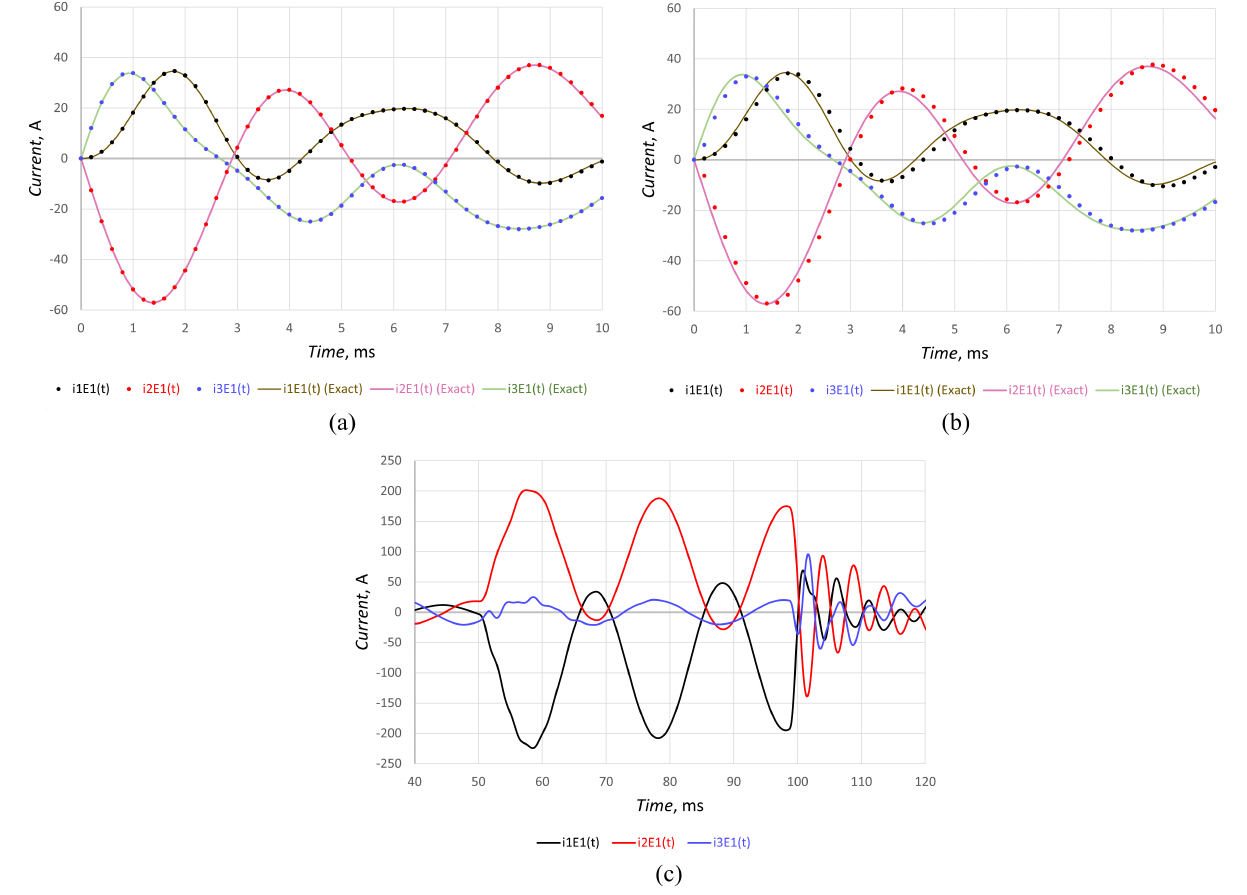
Figure 13. Waveforms of the currents of the structural element E 1 in a transient state caused by switching on of the three-phase supply voltage system (( a ) the AVIS method and ( b ) the trapezoidal rule) and the currents of this structural element during the short circuit (( c ) the AVIS